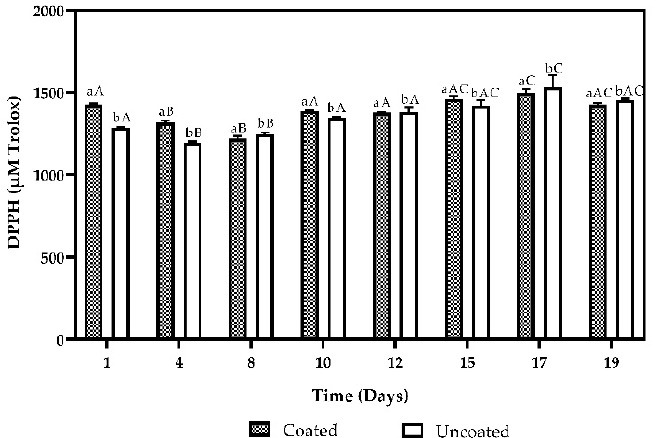
Figure 5. Antioxidant activity by the DPPH method and total phenol content of coated and uncoated fruits. The averages with a common letter are not significantly different according to the Tukey test ( p ≥ 0.05). Uppercase letters differences between days and lowercase letters differences between material coated and uncoated fruits.